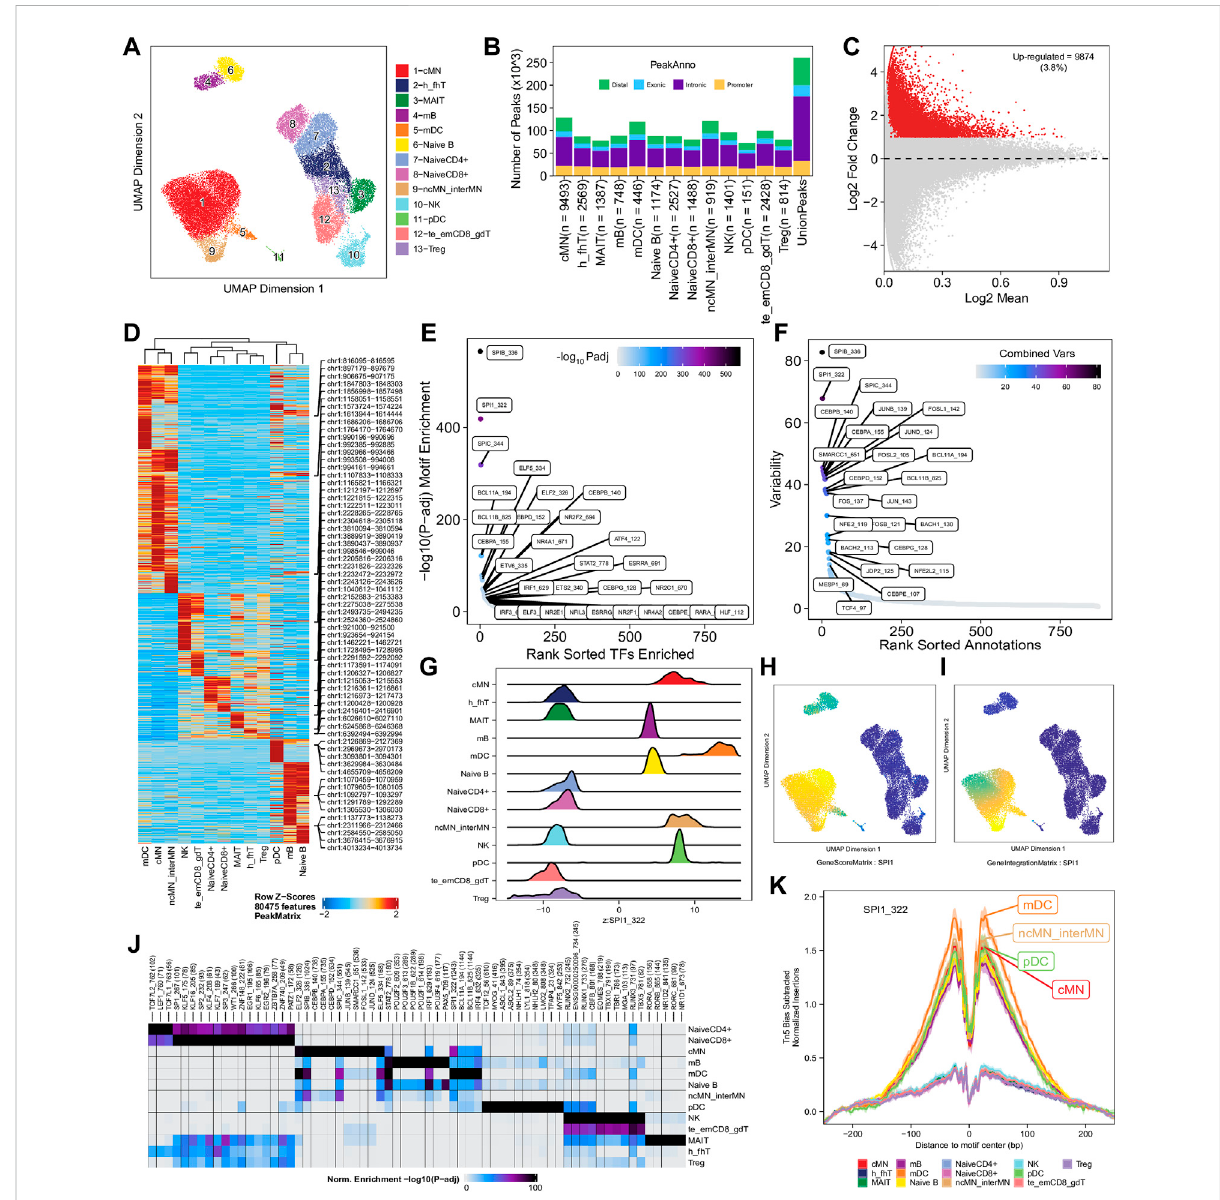
FIGURE 4 Functional analysis of annotated clusters of the human PBMCs. (A) UMAP plot showing annotated clusters identi fi ed in the human PBMCs by integrating with the human PBMC scRNA-seq data. cMN, classic monocytes; h_fhT, T helper and T follicular helper cells; MAIT, mucosal-associated invariant T cells; mB, memory B cells, mDC, myeloid dendrtic cells; Naive B, naive B cells; NaiveCD4+, naive CD4 + T cells; NaiveCD8+, naïve CD8 + T cells; ncMN_interMN, non-classic monocytes and intermediate monocytes; NK, natural killer cells; pDC, plasmacytoid dendritic cells; te_emCD8_gdT,terminaleffectorCD8 + Tcells, effectormemory CD8 + Tcells and γδ Tcells; Treg, Tregulatory cells. (B) Distribution ofreproducible peaks among different genomic features (promoter, intronic, exonic, and distal regions) in each cell type. (C) MA plot showing peaks preferentially accessible in intermediate and non-classic monocytes (FDR < 0.01 and log 2 FC ≥ 1). (D) Heatmap showing 80,475 marker peaks across the 13 annotated clusters. (E) Dot plot showing top motifs enriched among marker peaks of intermediate and non-classic monocytes (ncMN_interMN). (F) Dot plotshowingmotifsoftopvariabilityscoresacrossallthe13celltypesdeterminedbyChromVAR. (G) Ridgeplotsshowingdistributionsofthe Z-score of motif deviation scores for SPI1_322 in each cell type. (H,I) UMAP plots showing gene scores and pseudo expression of a monocyte- speci fi cTF,SPI1,whosemotifishighlyenrichedinmonocytes(cMN,interMN,andncMN)anddendriticcells(mDCandpDC)andisofhighdeviations across clusters. (J) Heatmap showing normalized enrichment score, -log 10 (adjusted p -value), of top TF motifs across the different cell types. (K) Aggregate footprints of SPI1_322 in each cell